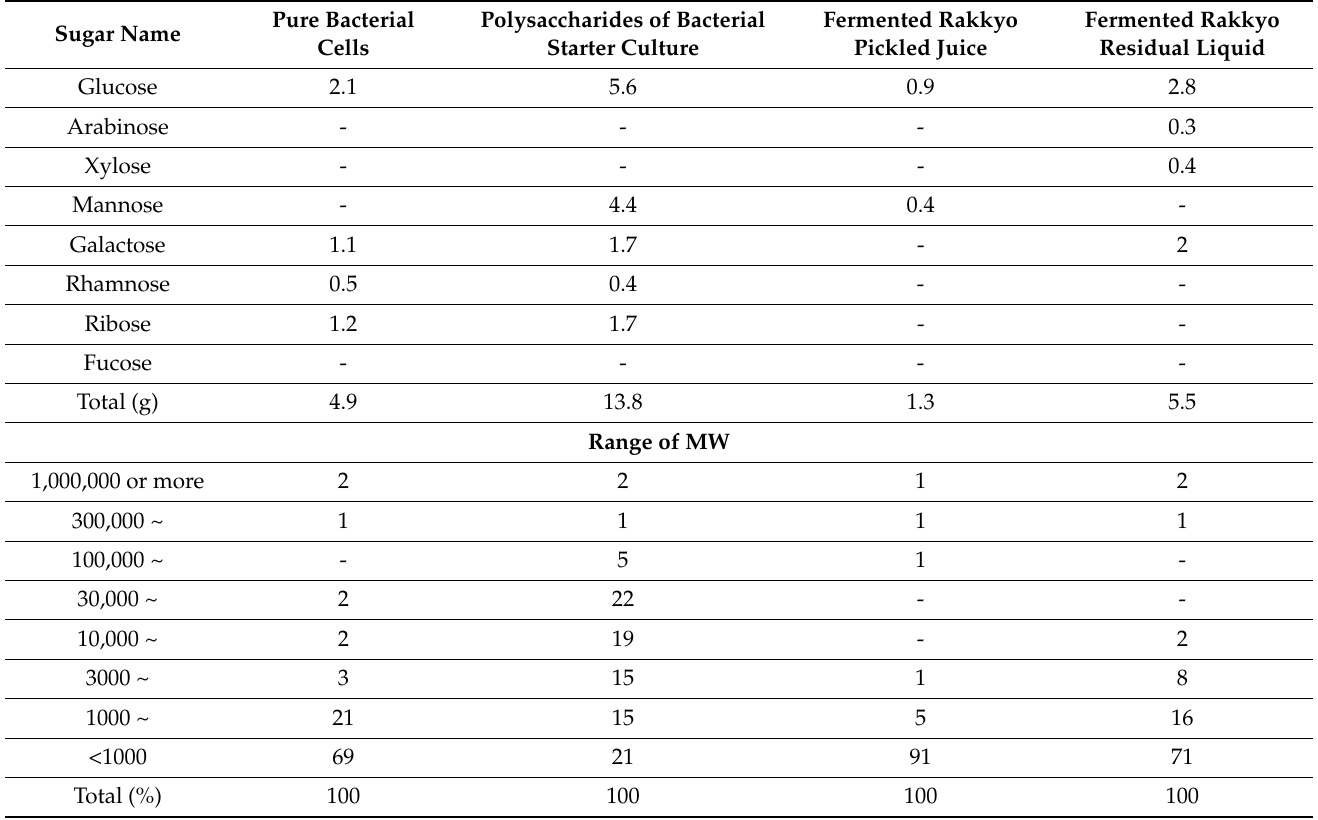
Table 2. Individual sugar composition and their category based on molecular weight (MW) in each 100 g